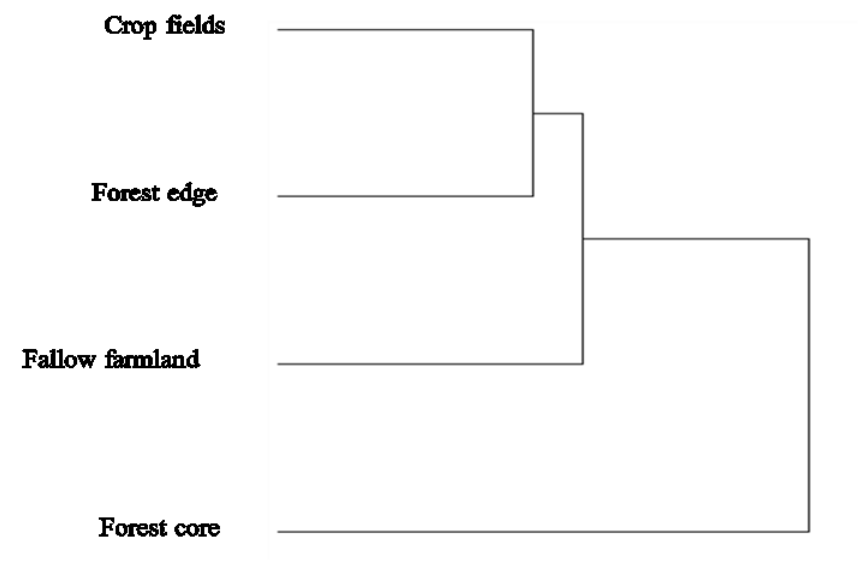
F IGURE 4: Cluster analysis of bee species composition in Kaya Muhaka Forest and surrounding farmland: X1-Crop fields, X2-Fallow farmland, X3-Forest core, X4-Forest edge.